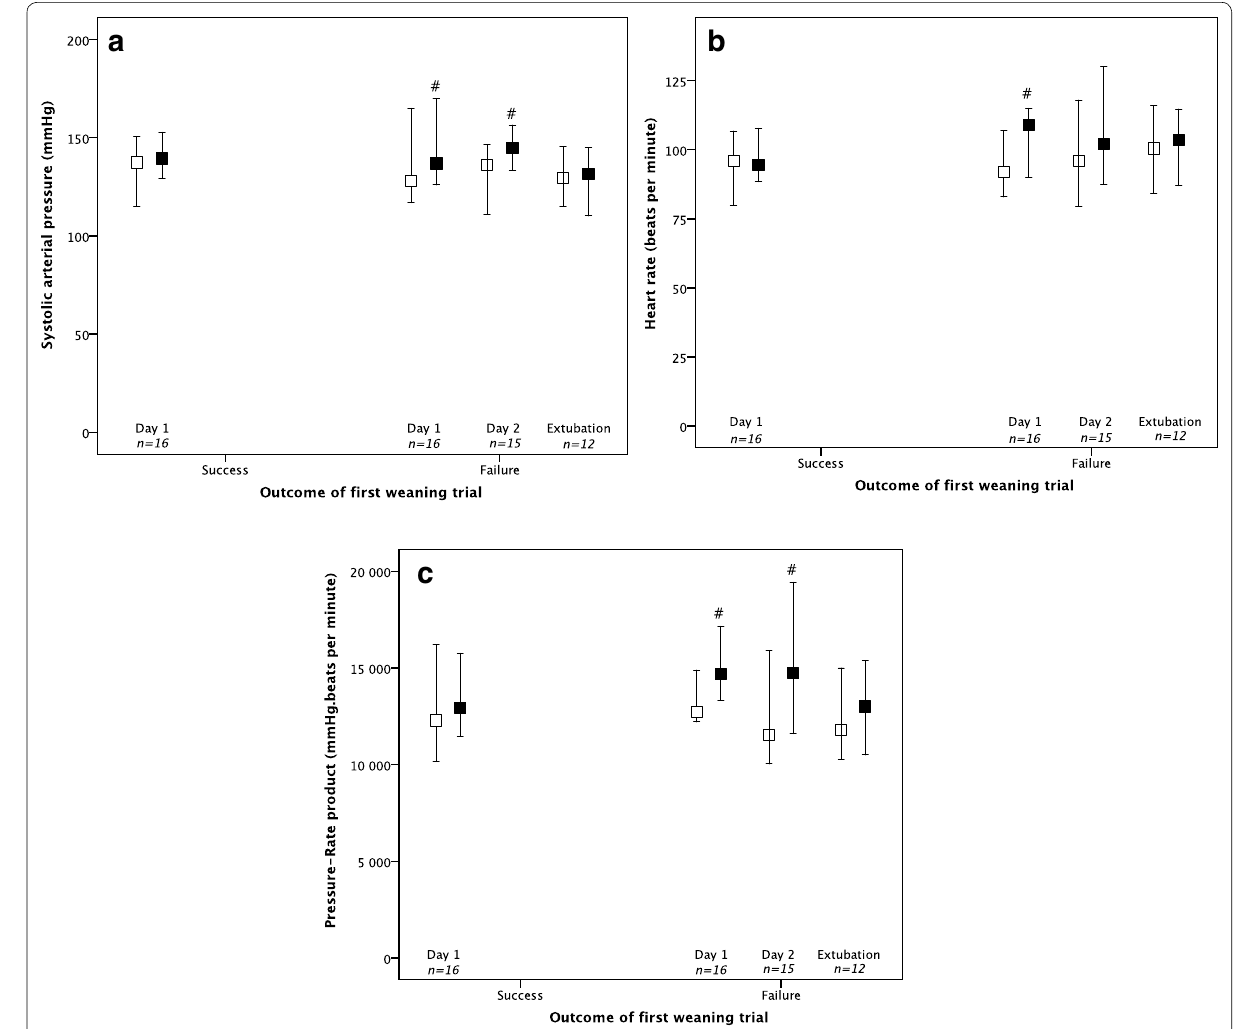
Fig. 2 Systolic arterial pressure ( a ), heart rate ( b ) and pressure‑rate product ( c ) at the start (white square) and the end (black square) of consecutive weaning trials during the weaning process ( n 31), according to first trial outcome (success or failure). # p value < 0.05 as compared to the start of = weaning trial (Wilcoxon